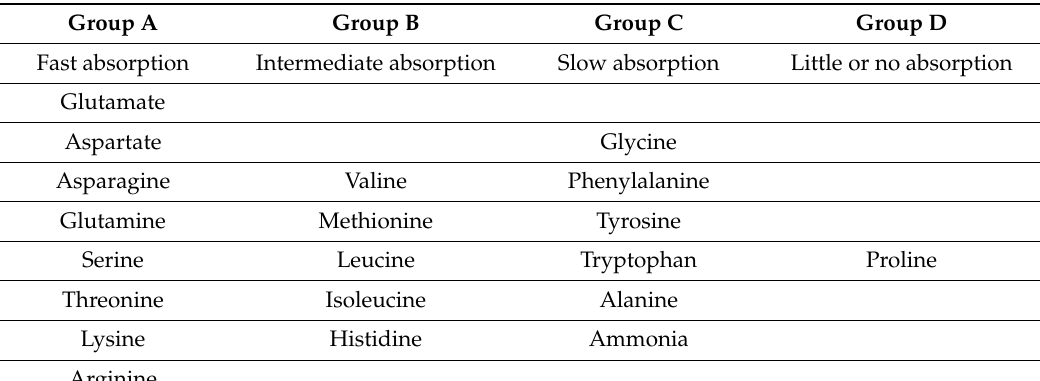
Table 1. Uptake of amino acids from wort. From Jones and Pierce (1964)